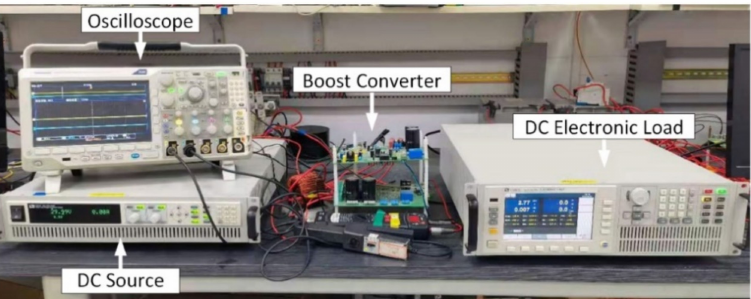
Figure 14. Experimental system setup.